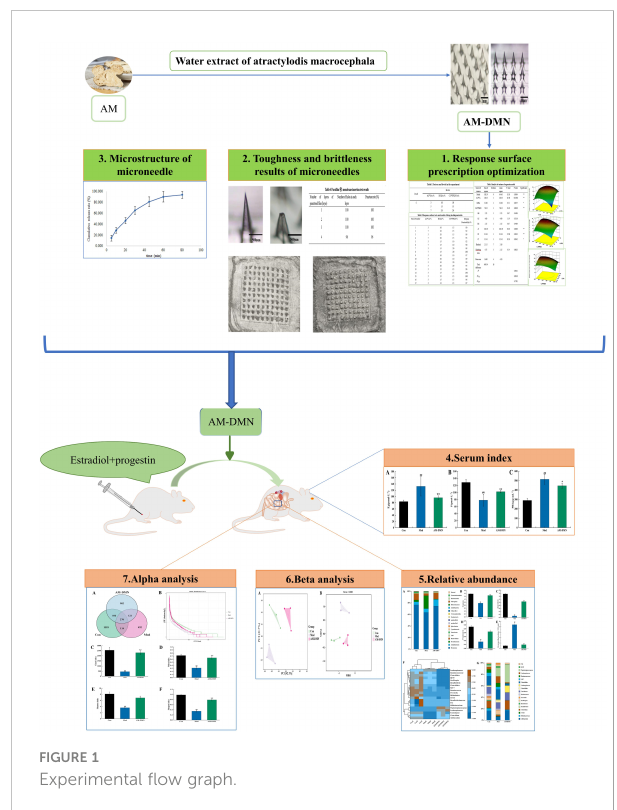
FIGURE 1 Experimental fl ow graph.